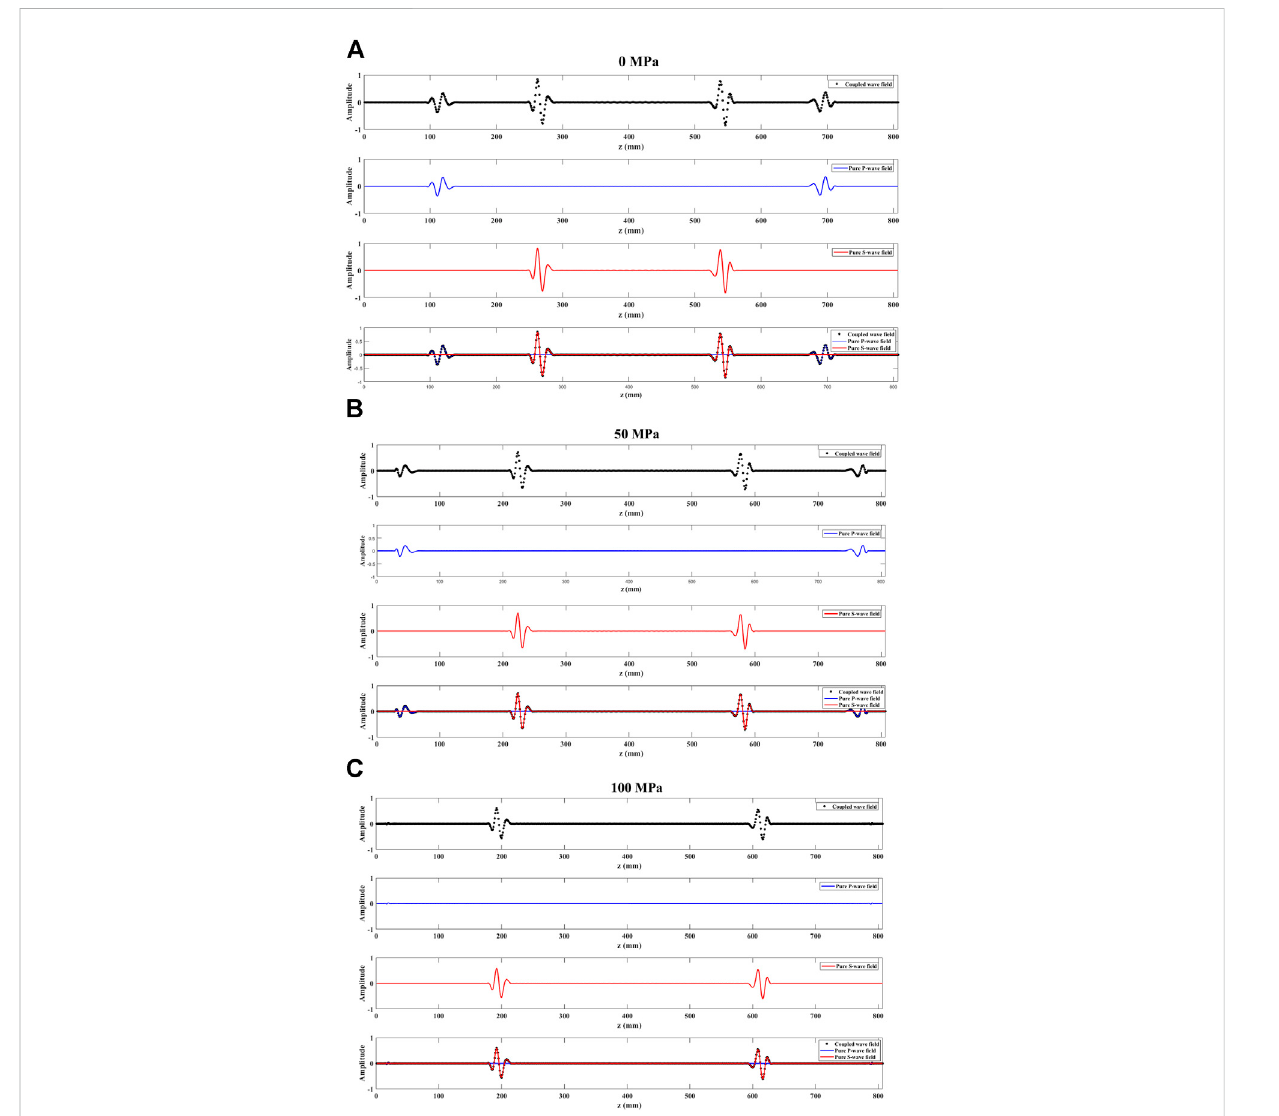
FIGURE 6 Recordsof x =250 mminsnapshotsaboveforvariouscon fi ningstresses( (A) :0MPa; (B) :50MPa; (C) :100MPa).(Theblackdottedlinesindicate records of coupled wave fi eld; the blue solid lines denote records of pure P-wave fi eld; the red solid lines represent records of pure S-wave fi eld). Decoupled acoustoelastic simulation under uniaxial